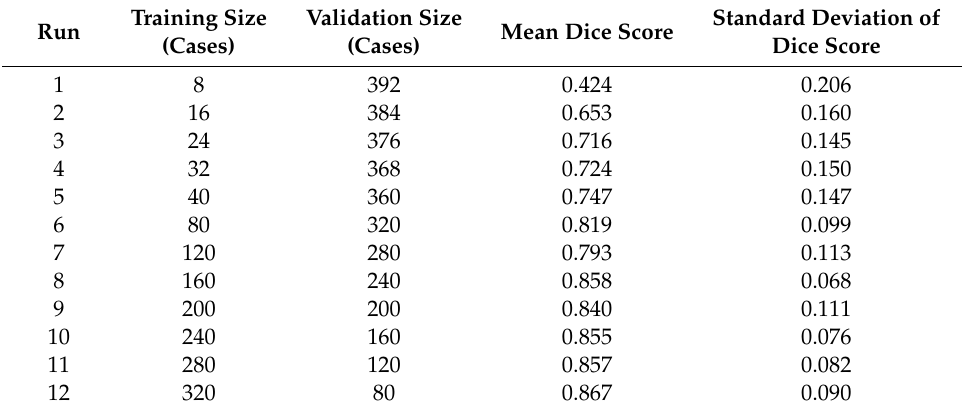
Table 2. Mean Dice score and standard deviation of Dice score for 12 training sizes.